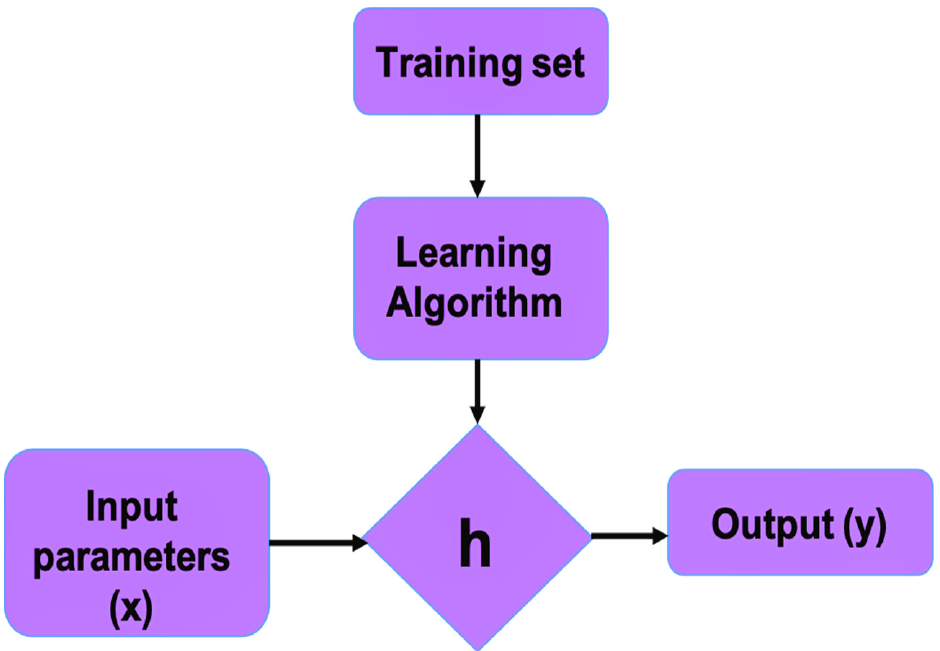
Figure 10. Basic scheme for initial implementation of ML algorithms (h : x → y) where h represents a hypothesis function that maps the input parameters (x) to the output (y) and selects a suitable learning algorithm to be used for further prediction.